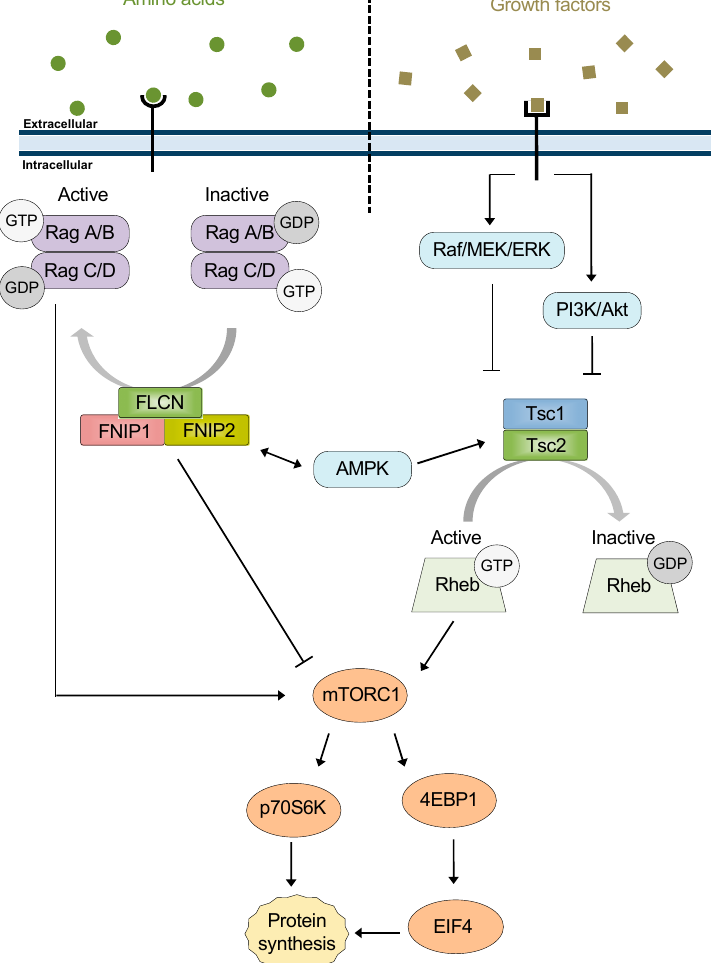
Figure 1. FNIPs and Tsc1 in the mTOR pathway. The mTOR pathway is a cellular signaling hub that integrates signals from several pathways and controls protein synthesis. A simplified schematic representation is shown to highlight the role of the FLCN/FNIPs and TSC complexes as mTOR regulators through GAP activity of RagA/C and Rheb, respectively.